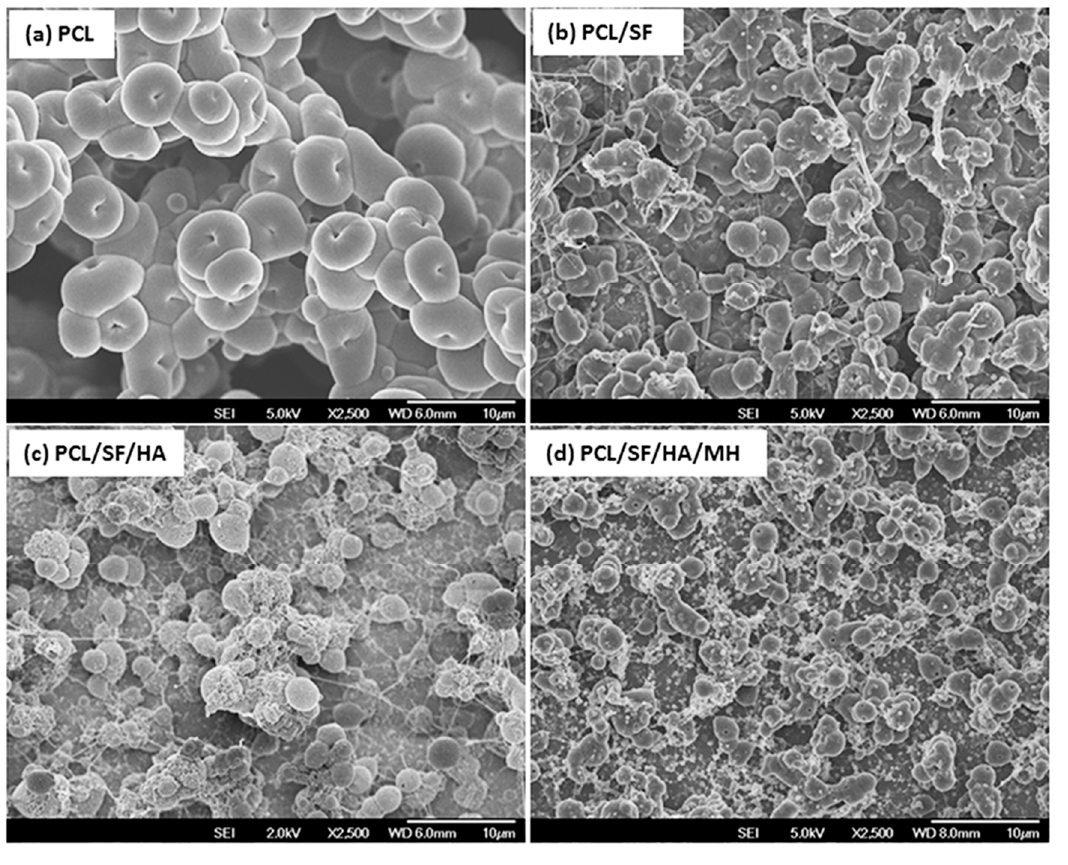
Figure 1. Field emission scanning electron microscope (FESEM) images of the electrosprayed micro/nanoparticles ( a ) polycaprolactone (PCL); ( b ) Polycaprolactone/silk fibroin (PCL/SF); ( c ) Polycaprolactone/silk fibroin/hyaluronic acid (PCL/SF/HA) and ( d ) Polycaprolactone/silk fibroin/hyaluronic acid/minocycline hydrochloride (PCL/SF/HA/MH) (0.54 ± 0.12 to 3.2 ± 0.18 µm). (Scale bar: 10 µm). Table 1. Particle size measurement of biocomposite nanoparticles.